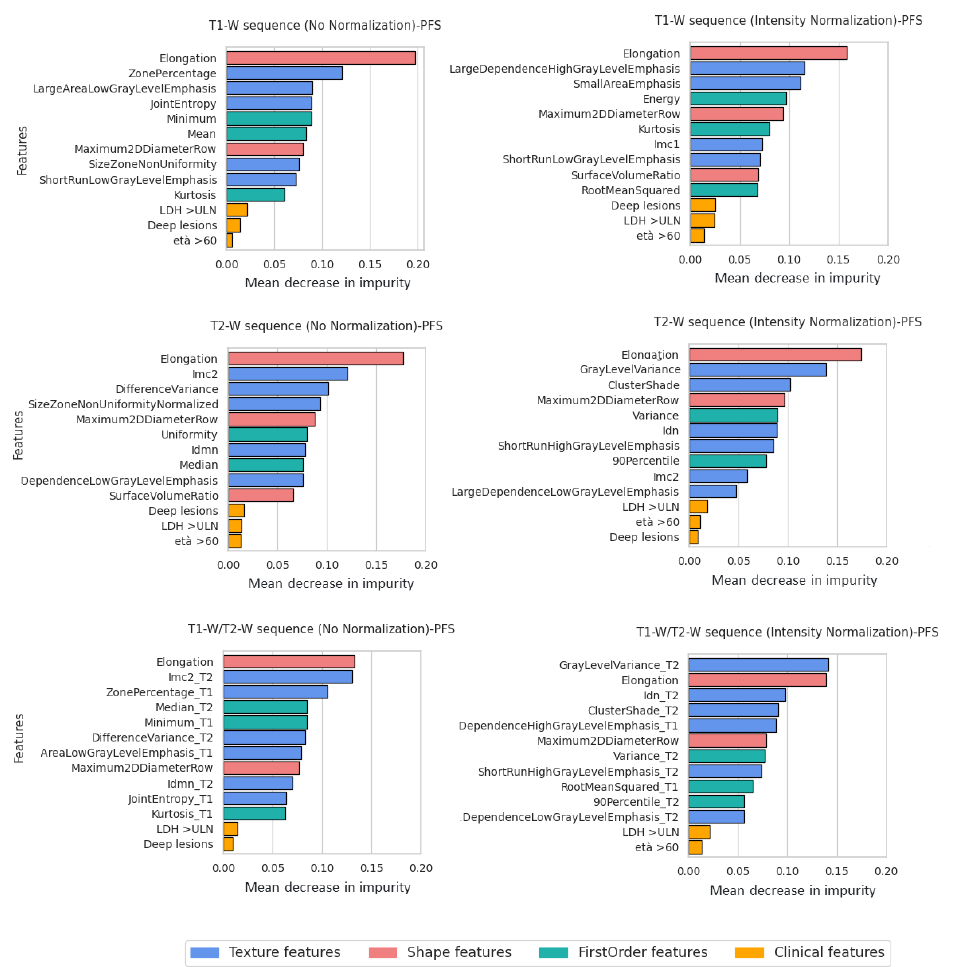
Figure 6. Feature importance for all MRI sequences with and without normalization (PFS classification task). Features were grouped using different colors for shape features, texture features, first order features and clinical